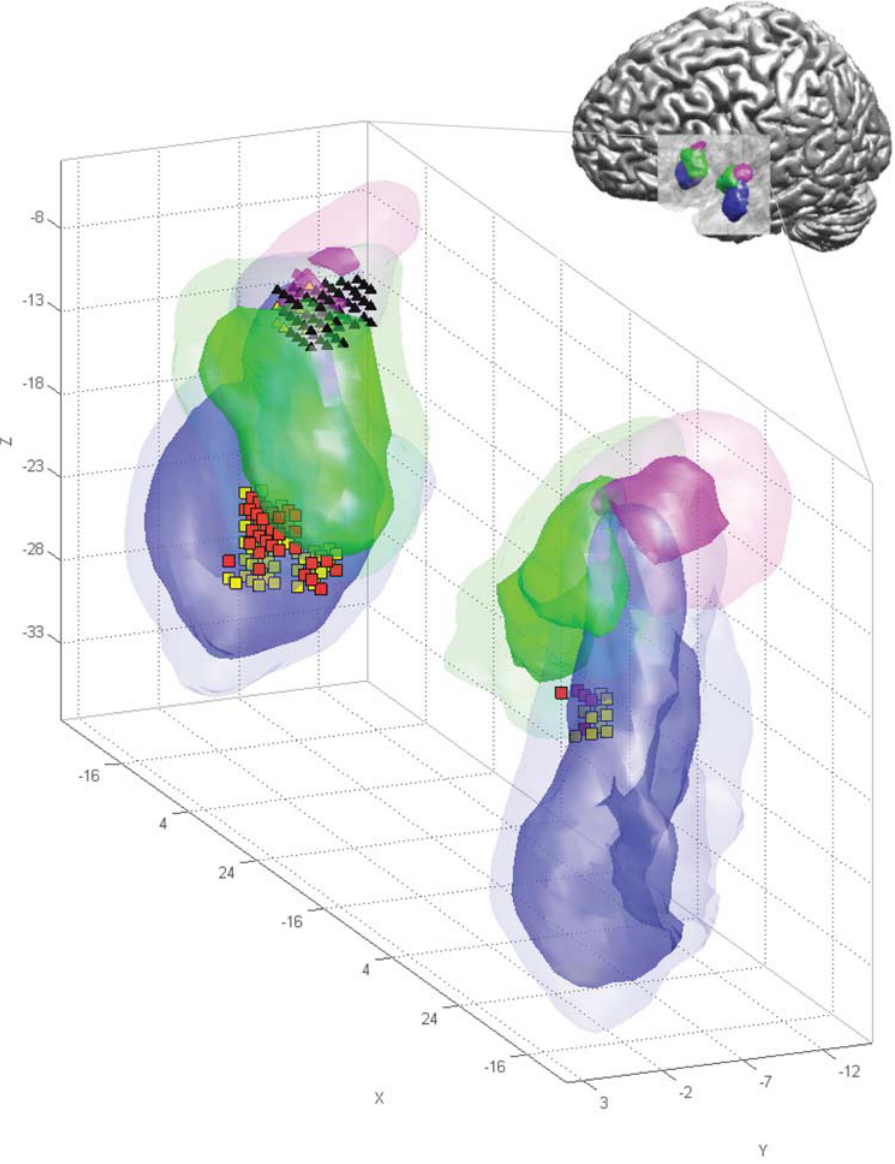
Figure 4. Human amygdala responses to music in probabilistically defined anatomical regions. The volumes with at least 50% and 80% probability to belong to the three major amygdala subregions: LB=laterobasal group (blue), SF=superficial group (green), and CM=centromedial group (magenta) are rendered with high (for 50% probability) and low (for 80% probability) transparency. Voxels with a significant increase in BOLD signal to music presentation are displayed as red or yellow squares (p , 0.05, corrected for multiple comparisons, see material and methods for further details). Voxels with a significant signal decrease are displayed as black or yellow triangles. Anatomical probabilities for red and black responses were 50% to 60%, for yellow responses 70% or above. The majority of significant effects was found in the left amygdala. Positive effects were found in both right and left LB and SF (c.f. Tab. 2), negative effects were localized in left LB, SF and CM. For visualization, probability maps were smoothed using a spatial filter with a 5 mm isometric Gaussian convolution